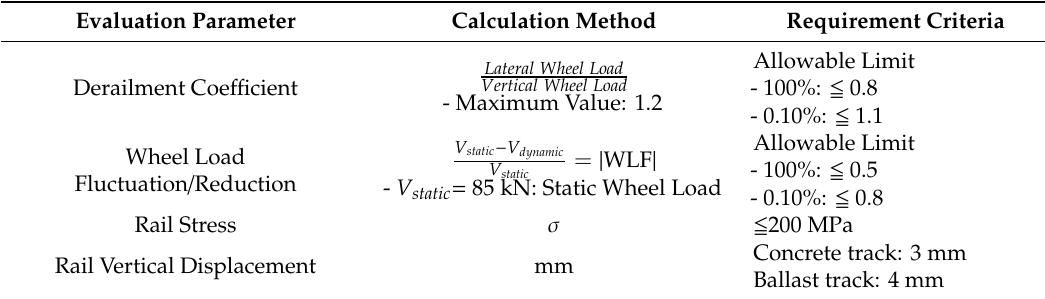
Table 5. Dynamic stability evaluation criteria.